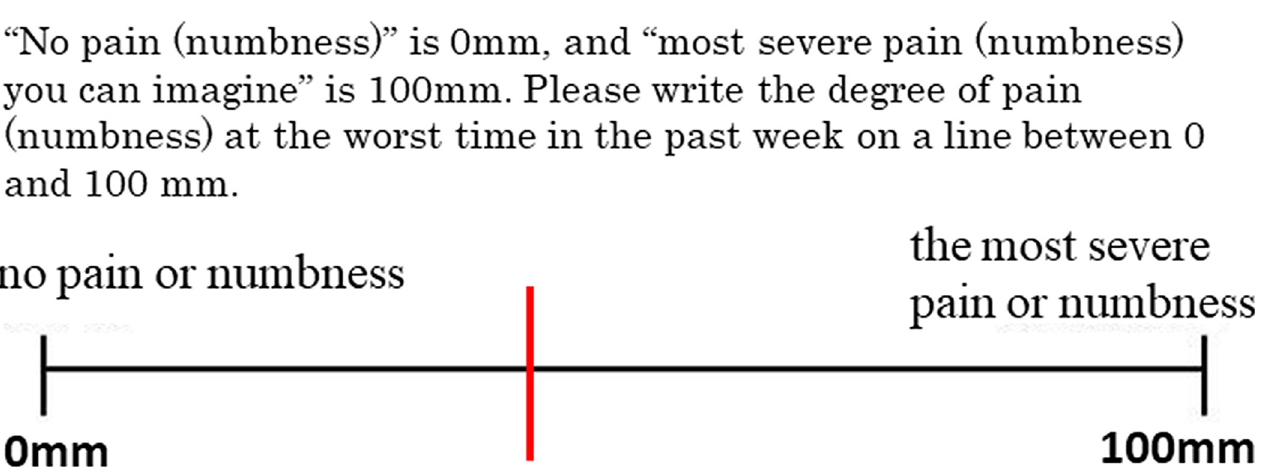
Fig 1. Visual analog scale; VAS. Assessment of the degree of low back pain, limb pain, and limb numbness.